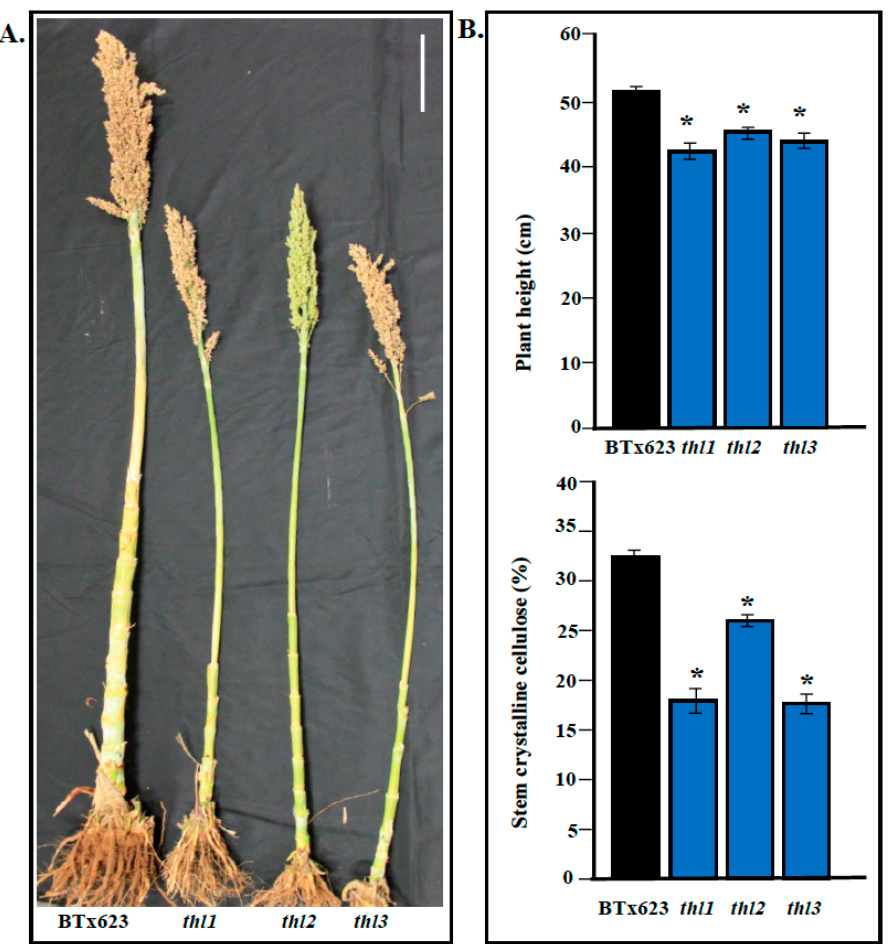
Figure 3. ( A ). Phenotype analysis of different thl mutants ( thl1 , thl2 , and thl3 ). Scale bar: 10 cm. ( B ). ( Upper panel ): Graph showing plant height differences between BTx623 and thl mutants ( thl1 , thl2 , thl3). ( B ). ( Lower panel ): Crystalline cellulose content analysis of BTx623 and thl mutants. * Represents significant